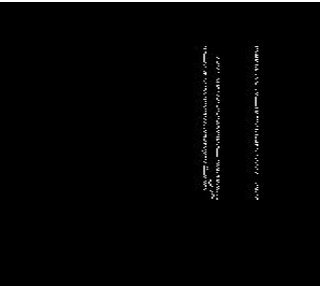
Figure 5 Image after Hough